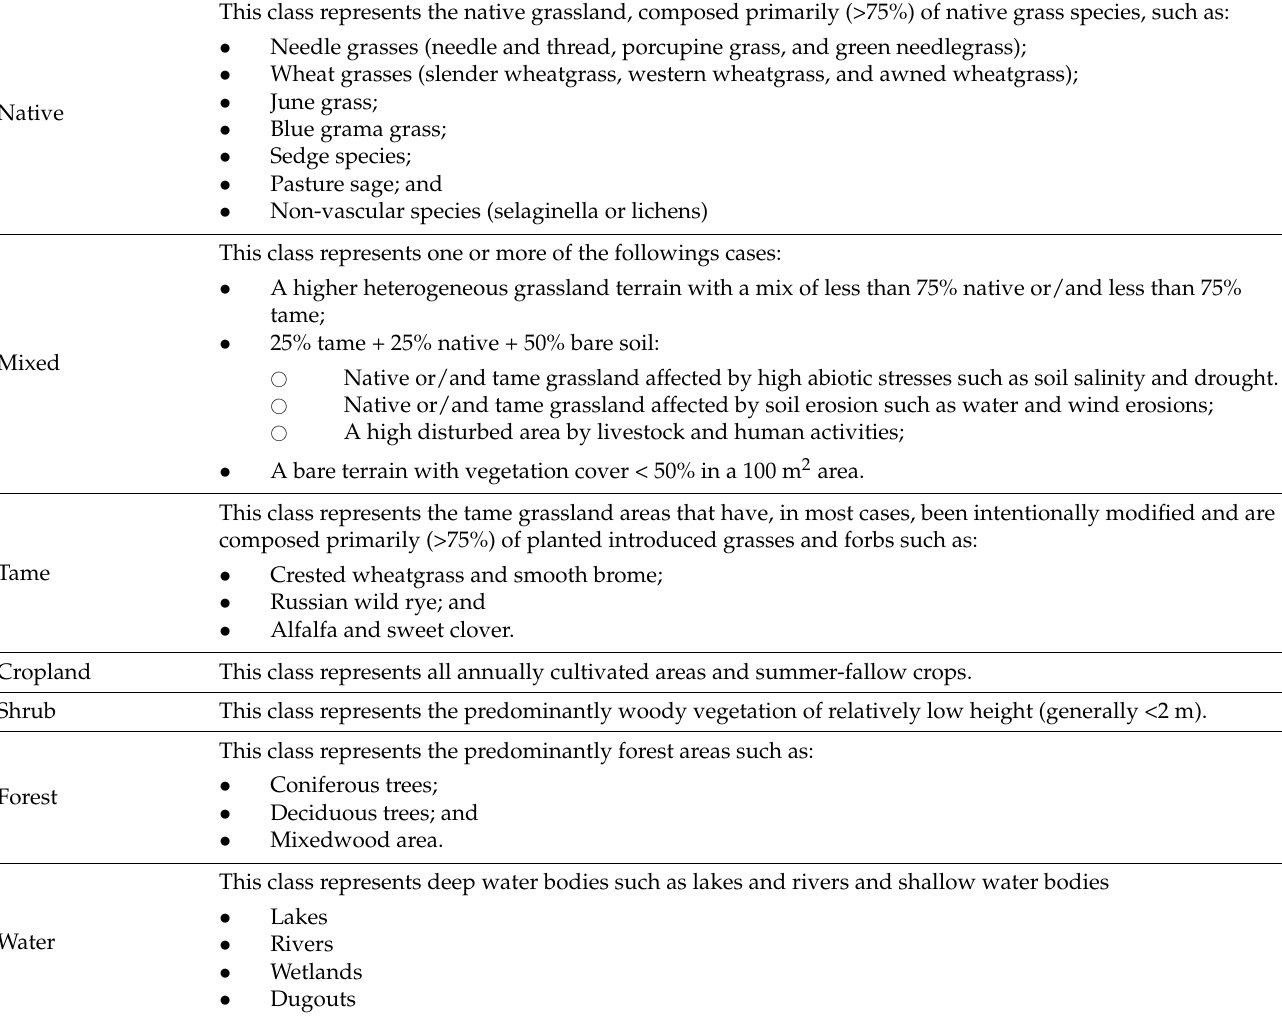
Table 1. The definitions of the classes that were chosen in the PLI project for field survey and mapping. Class Definition